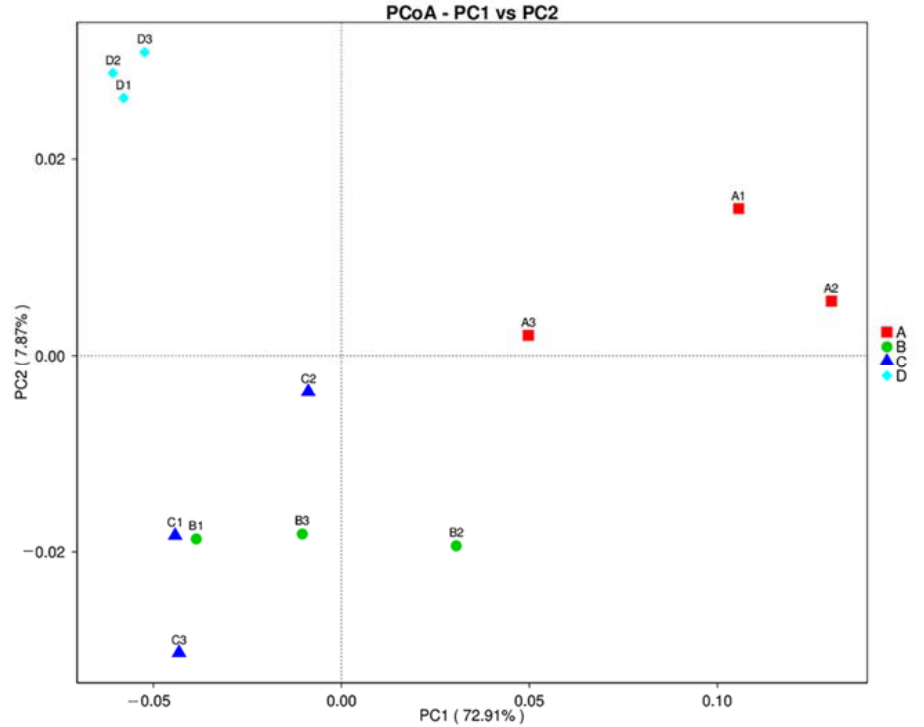
Figure 3. PCoA analysis of the bacterial composition similarities among treatments. Treatment A, an uninoculated control; B, inoculation with Paenibacillus sp. strain OL15 immobilized in agar; C, inoculation with Paenibacillus sp. strain OL15 immobilized in alginate; D, inoculation with a cell suspension of Paenibacillus sp. strain OL15.